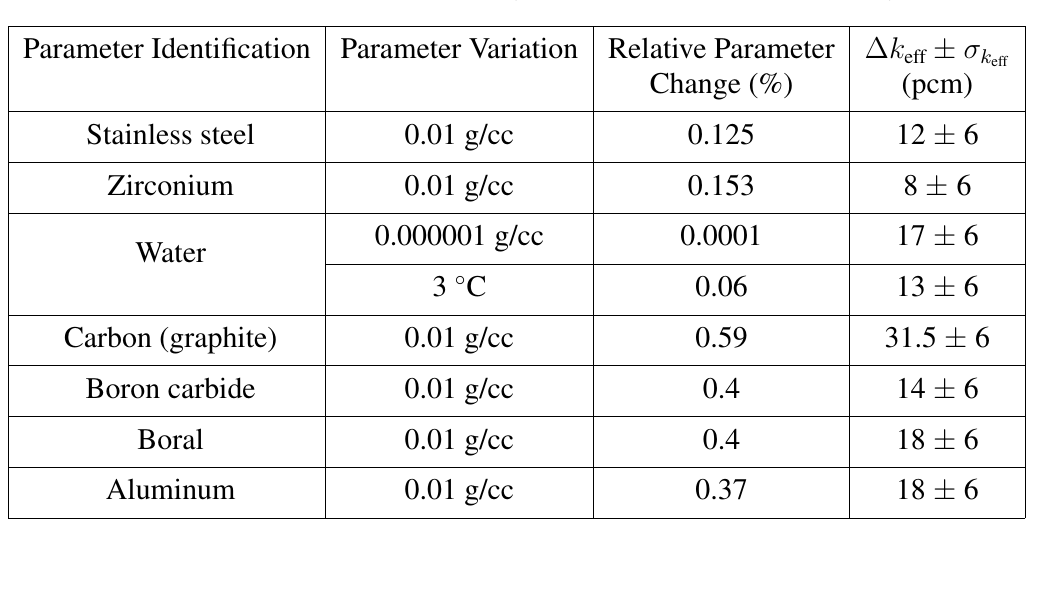
Table 3: Effect of Uncertainty in Non-fuel Material